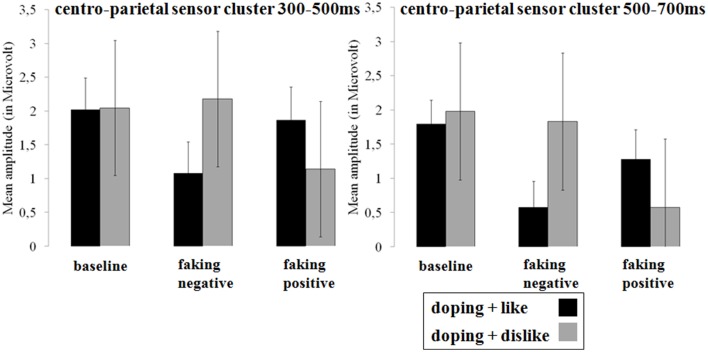
Mean amplitudes in microvolt for late effects over the centro-parietal sensor cluster. Error bars represent ±1 standard error of the mean (SEM).